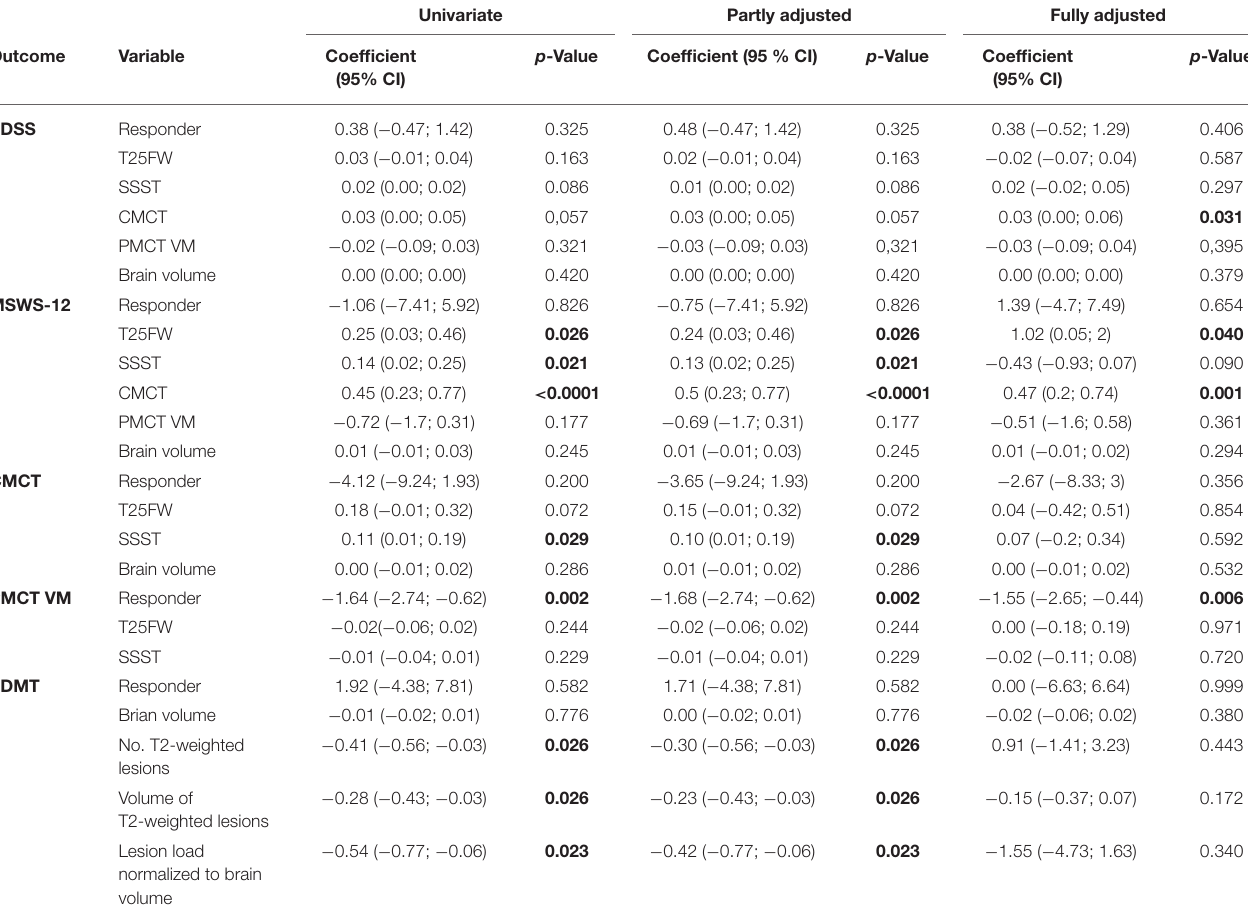
TABLE 4 | Linear mixed regression models and associations between disability, physical and cognitive performance, neurophysiology, and